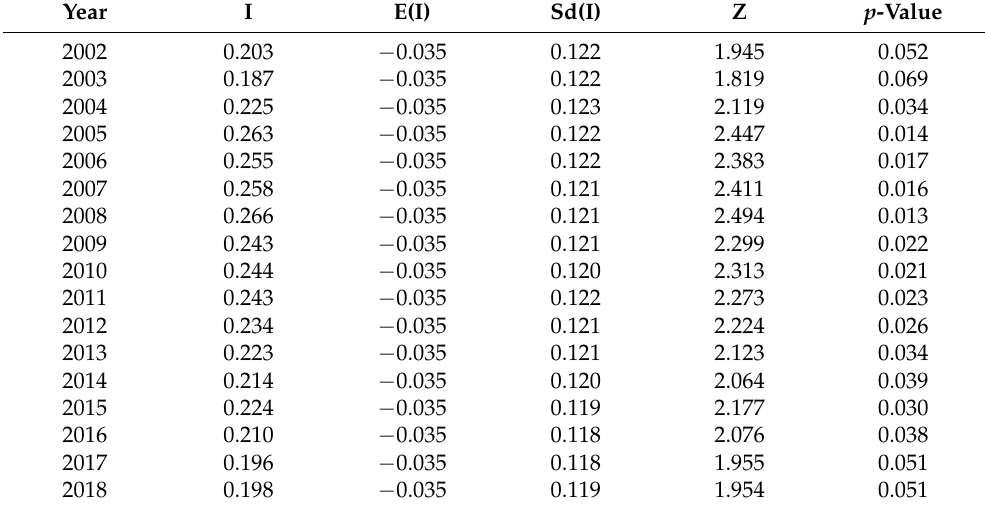
Table 7. The Moran’s I index.